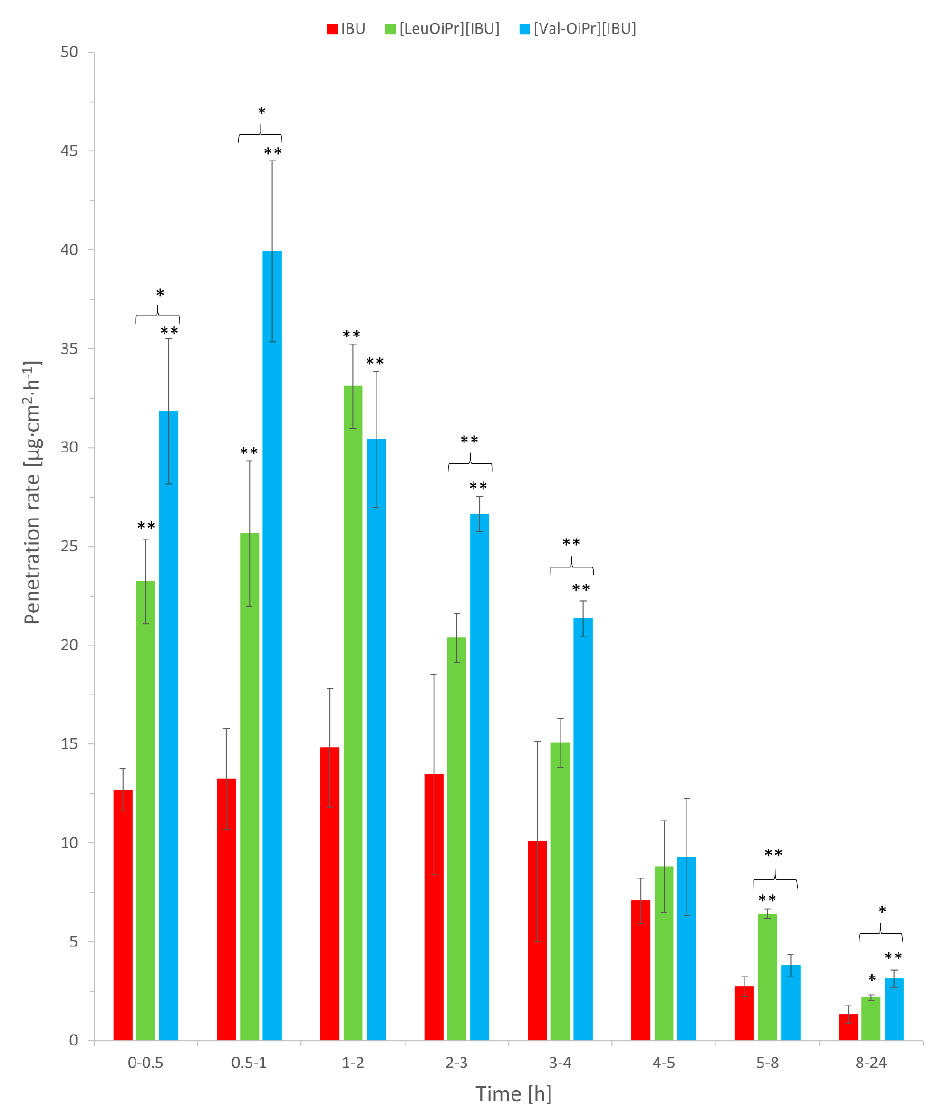
Figure 7. The permeation rate of IBU, [ValOiPr][IBU], and [LeuOiPr][IBU], permeated from BC into acceptor fluid. Mean values ± standard deviation, n = 3. Statistically significant difference from IBU was estimated using the ANOVA test. Double asterisk ** means statistical difference for p < 0.01, single asterisk * means statistical difference for p < 0.05. Brace { means statistical difference between two ibuprofenate